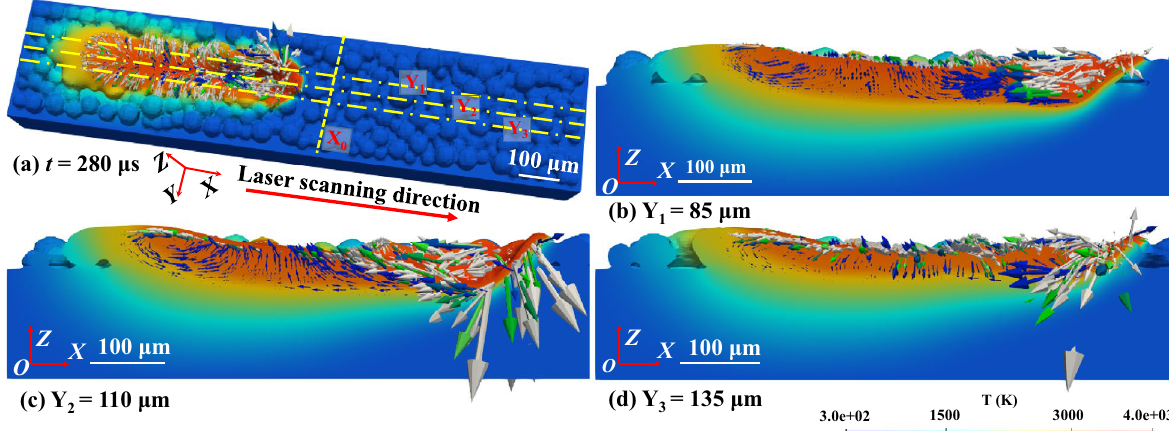
Figure 10 Serial longitudinal sections of LPBF tracks at 195